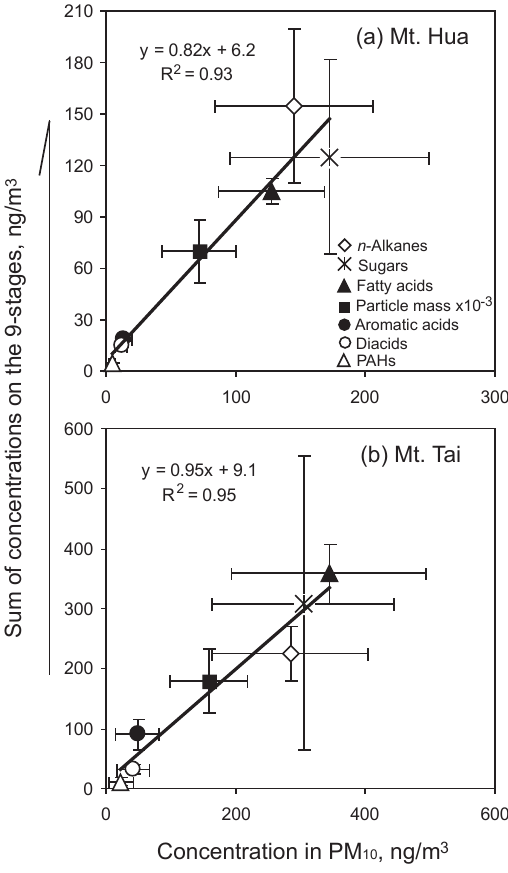
Fig. 2. An intercomparison of compound concentrations measured in the PM 10 and the size-segregated